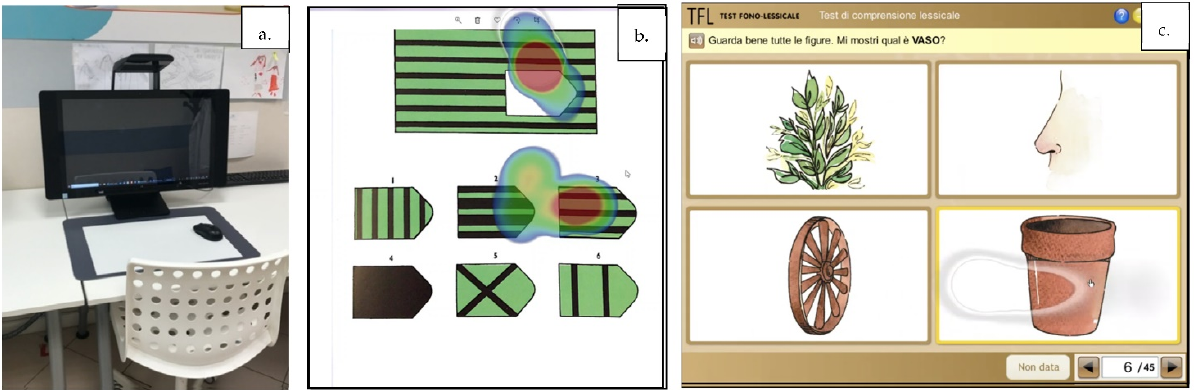
Figure 1. ( a ). Setting of the eye tracker system. ( b ). Scanned version of Raven ′ s Progressive Matrices in which the subject choses among 6 choices the best completing the design. The heatmap shows the most (red) and the least (blue) attention capturing sections. ( c ). Digital version of the Italian TFL test (Test Fono Lessicale of Italian language) analyzing the receptive Language. The subject’s eyes position is shown as a light-blue bubble on the screen. The test consists in 42 tables with 4 images each: the target, a phonological distractor, a semantic distractor, and a non-related image scrabbled in each table. The examiner shows and ask the subject to point the target with a simple question (“Guarda bene tutte le figure. Mi mostri quel’è..?, “Look carefully at all the figures. Show me where is …?”). In this example, the target is VASO (“flower vase” bottom right), the phonological distractor is NASO (“nose” top right) and the semantic distractor is PIANTA (“plant” top left).